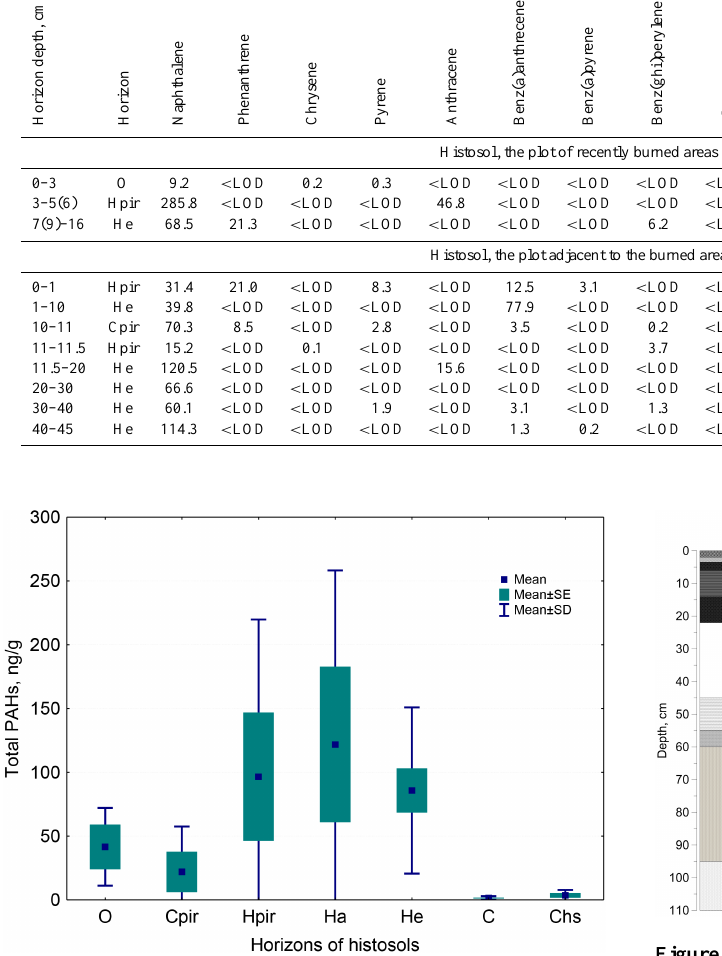
h , p t ond e z r i H o